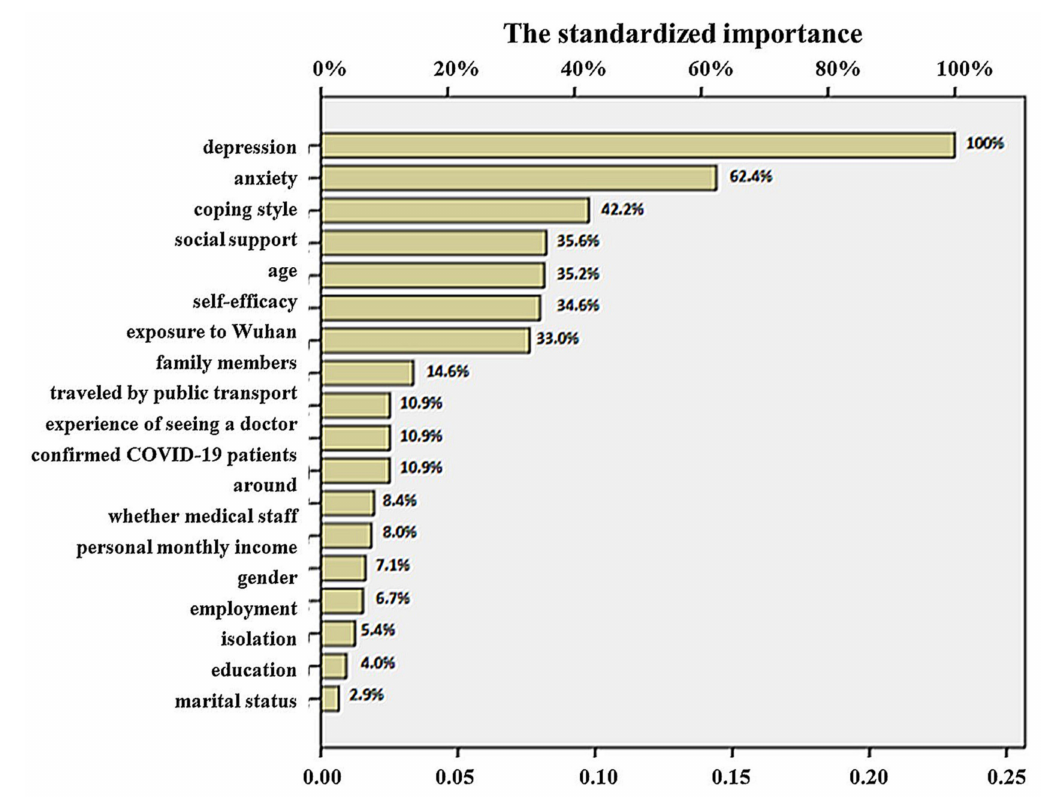
Figure 3. Importance of